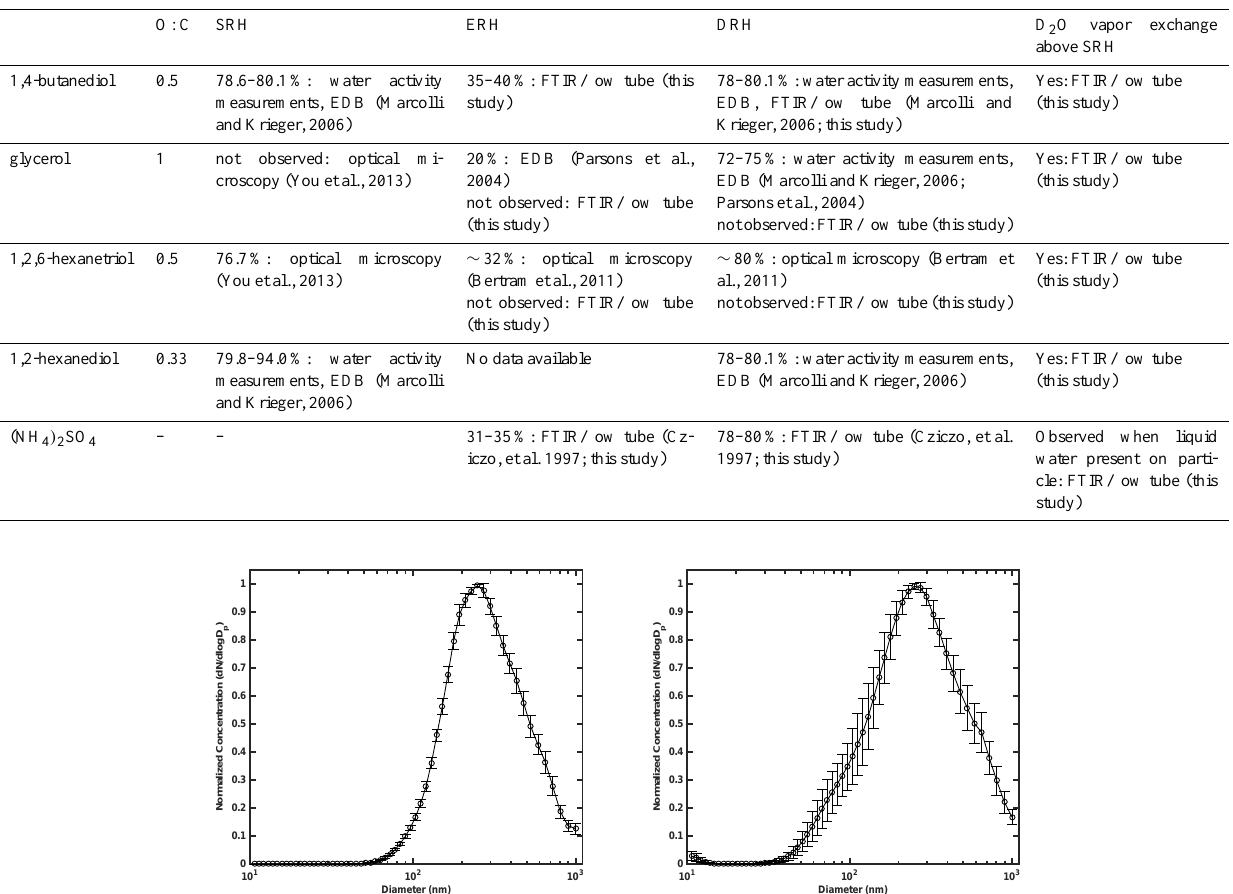
Table 1. SRH (phase-separation relative humidity), ERH (efflorescence relative humidity) and DRH (deliquescence relative humidity) points for ternary systems used in this experiment. The organic to ammonium sulfate ratio was 1.0 in all cases.